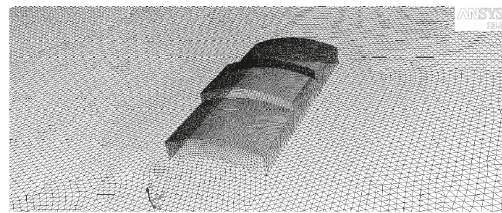
Figure 11: Mesh scheme of